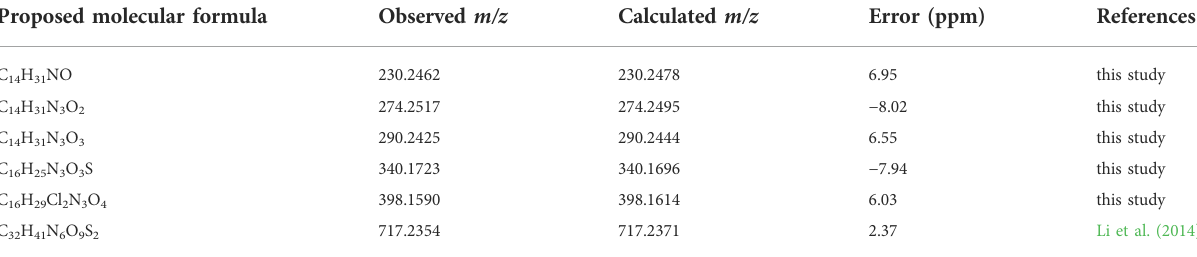
TABLE 1 Reaction products of CPO-mediated oxidation of ampicillin observed by LC/DAD/MS. Proposed molecular